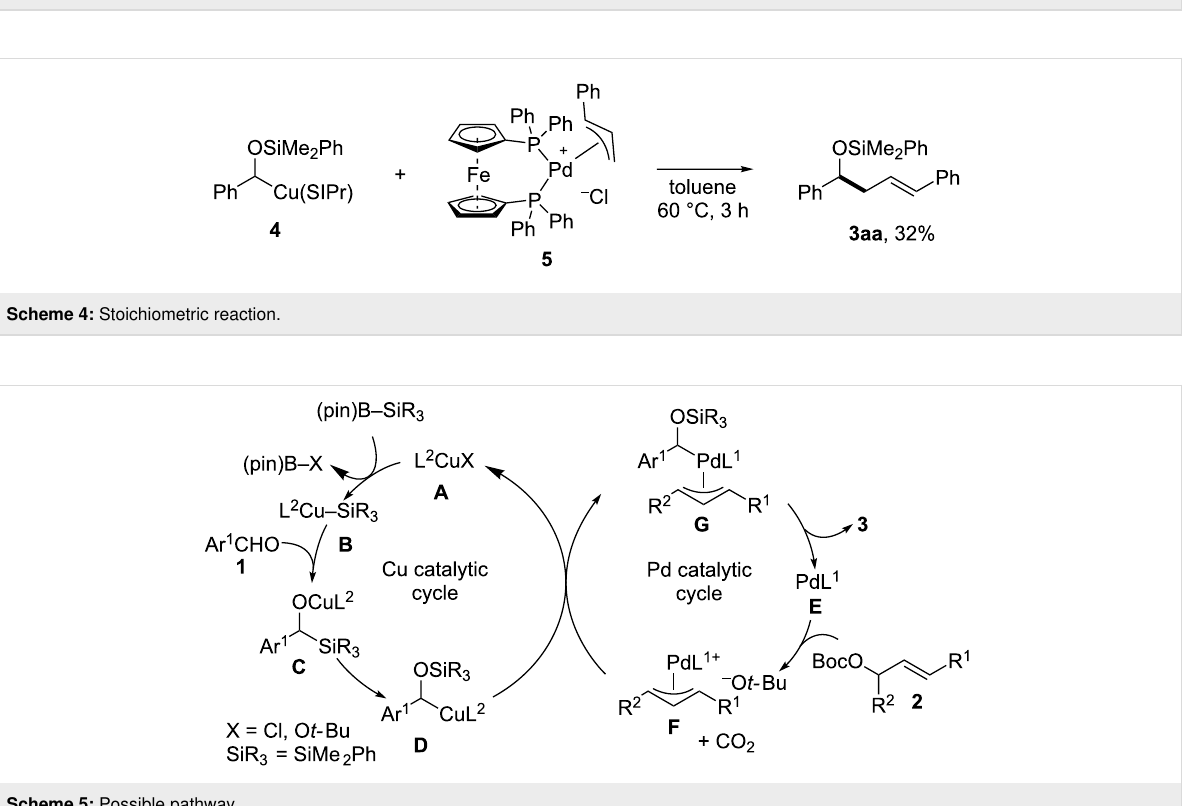
Scheme 5: Possible